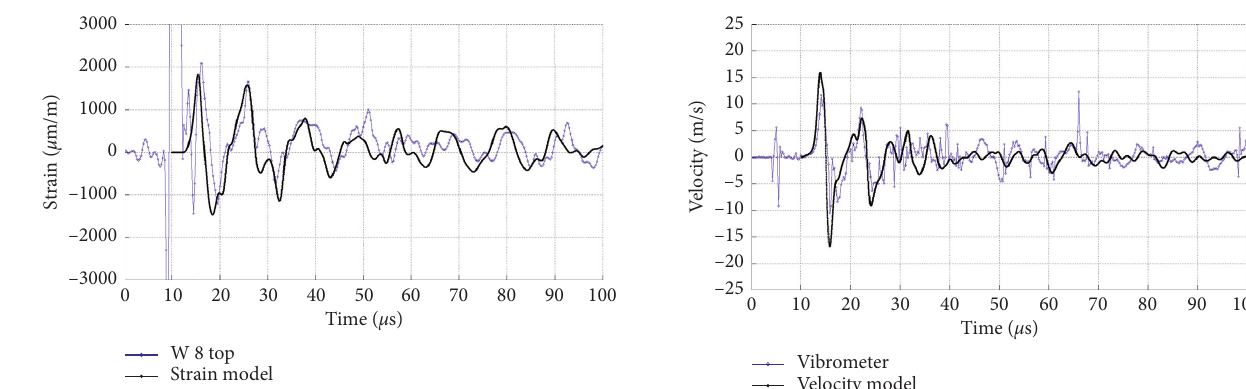
Figure 25: Results of the medium-intensity test on Inermet ® 180, radial velocity (blue) without smoothing function and simulated signal